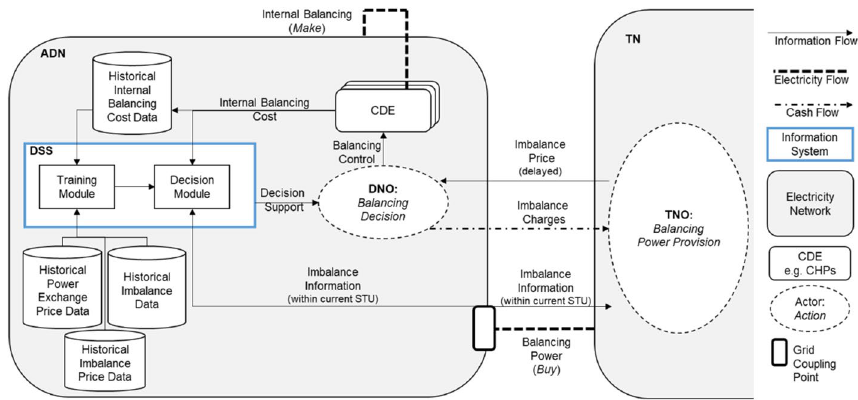
Fig. 3 Research setting: ADN with internal balancing controlled by a